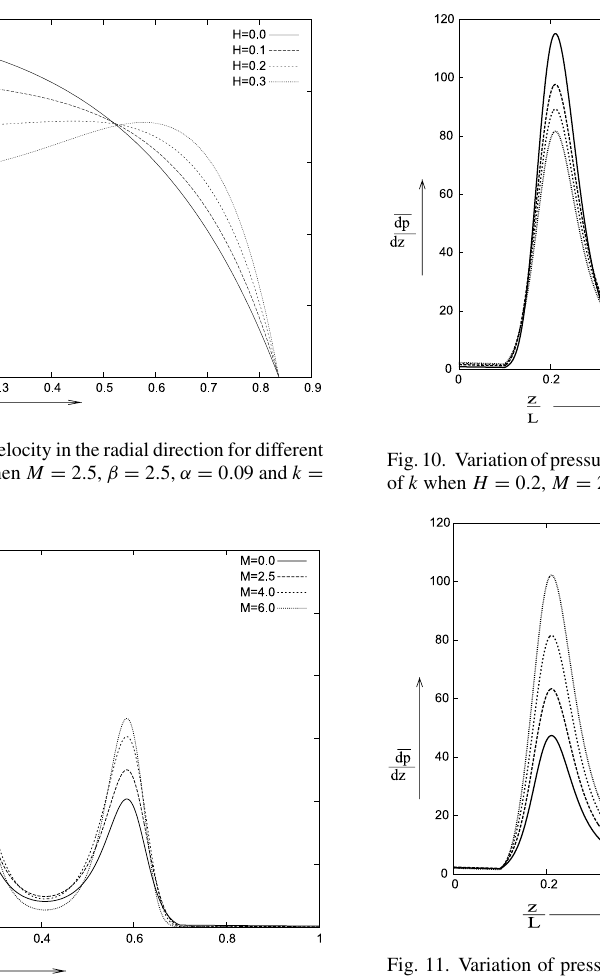
Fig. 11. Variation of pressure gradient ( H when M = 2 . 5, β = 2 . 5, α = 0 . 09 and k = 0 . 25. ¯ dp M dz ) for different values of